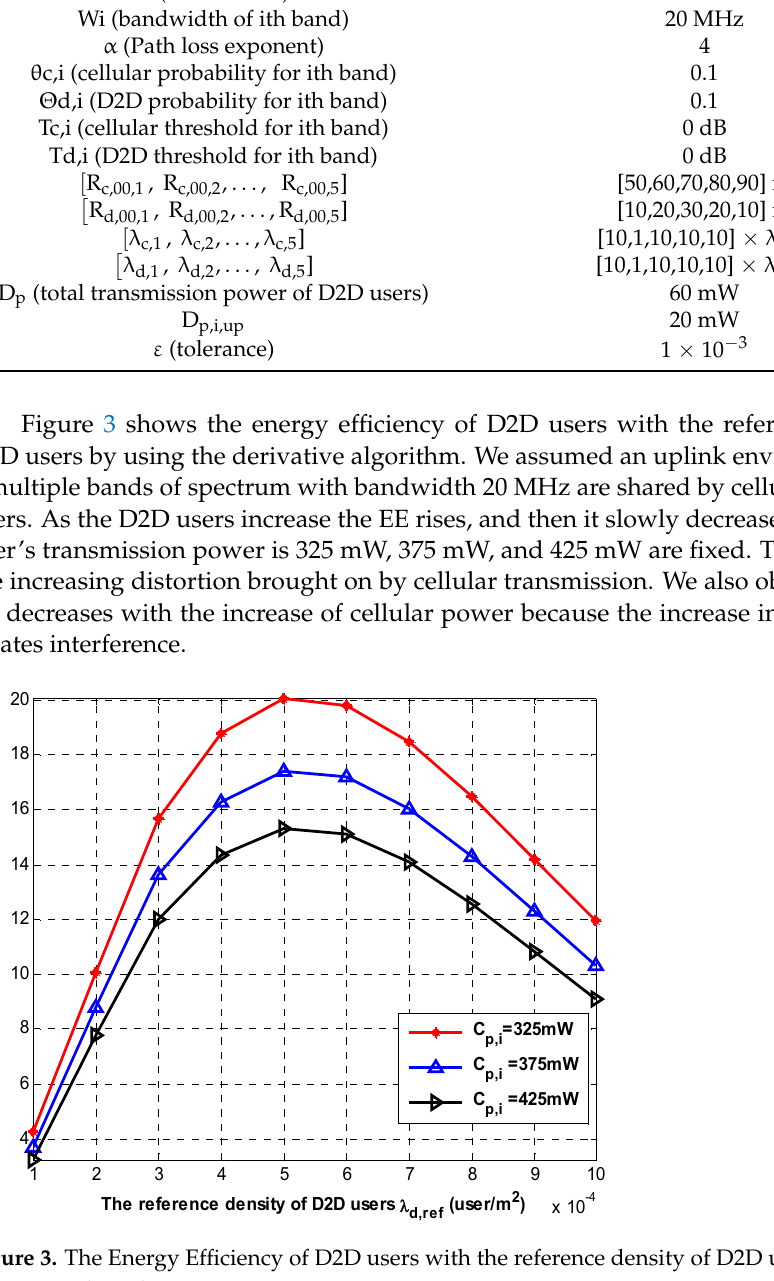
derivative algorithm. derivative